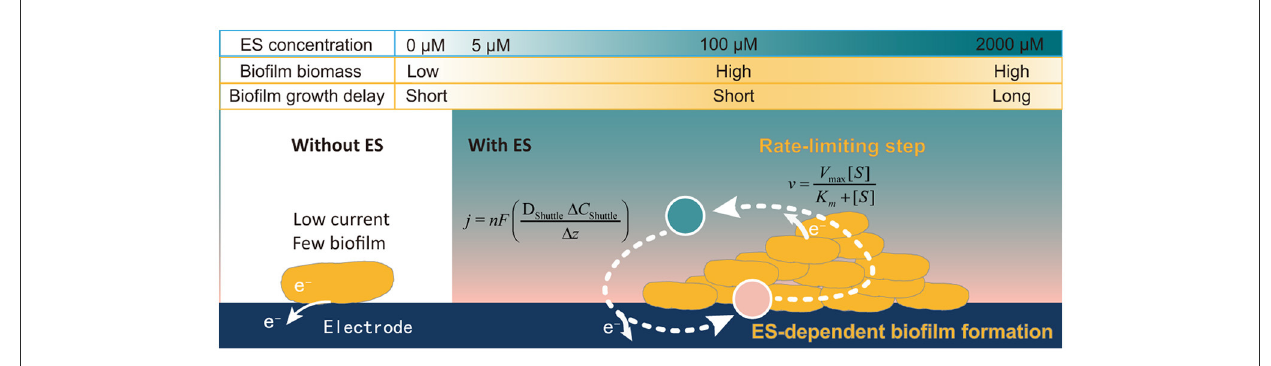
FIGURE7 Schematic representation of the ES concentration-dependent biofilm formation